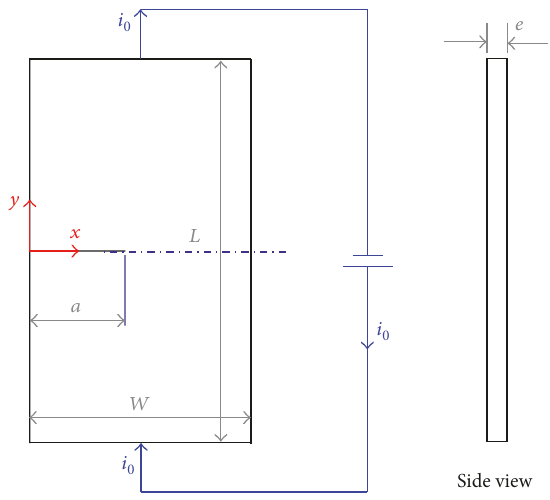
Figure 2: Geometric and loading